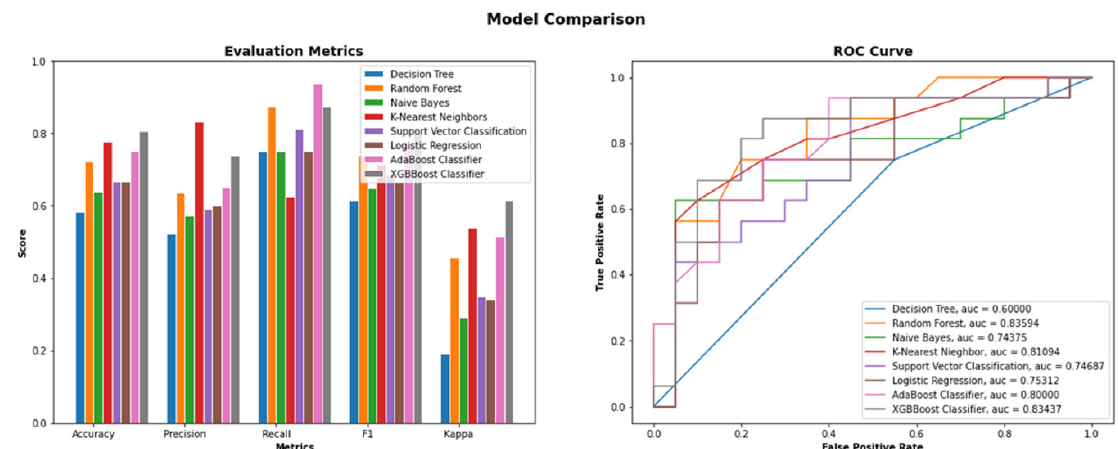
Figure 3. Comparison of Accuracy, Precision, Recall, F1-Score, Cohens Kappa Score, and AUC of the proposed ML-DTD.